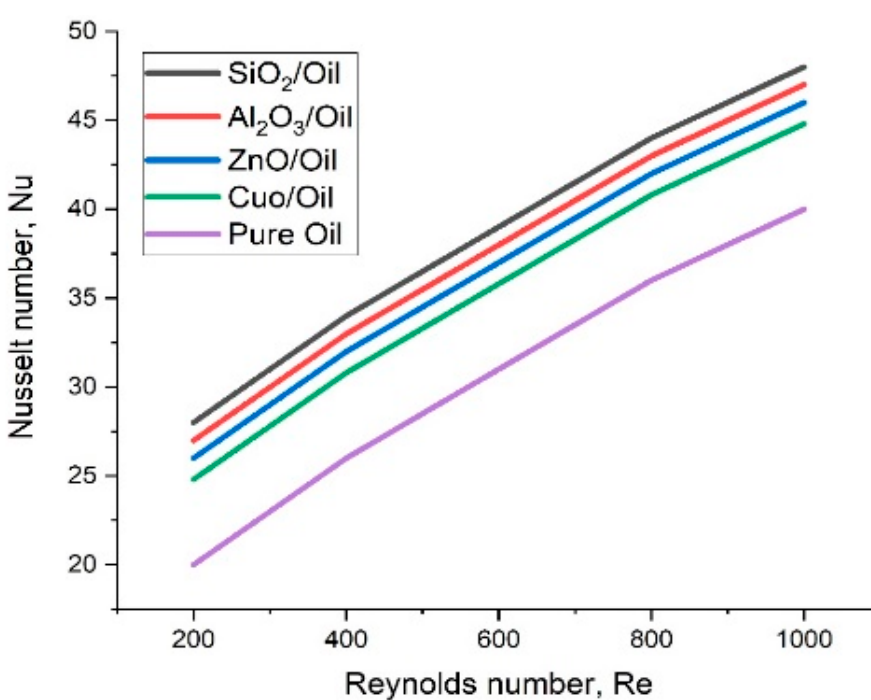
Figure 2. Comparison of 𝑁𝑢 vs. 𝑅𝑒 with different oil-based nanofluids.